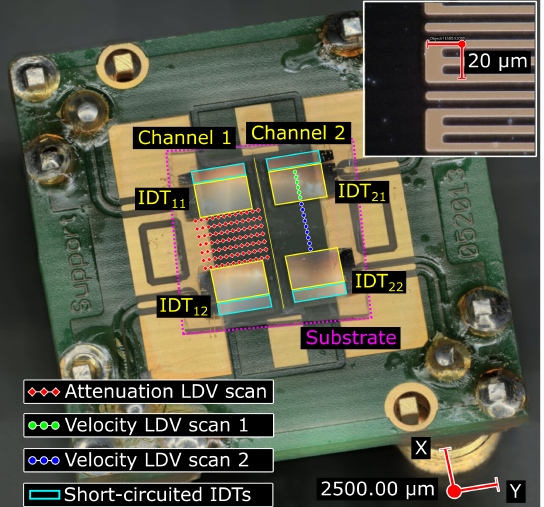
Figure 1. Microscopic image of the two-channel chemical sensor. The substrate tilt (magenta) and LDV scan regions (red, green, and blue markers) are visible. The positions of the markers do not correspond to the exact scanning points. The split electrode structure is depicted in the inset in the top right